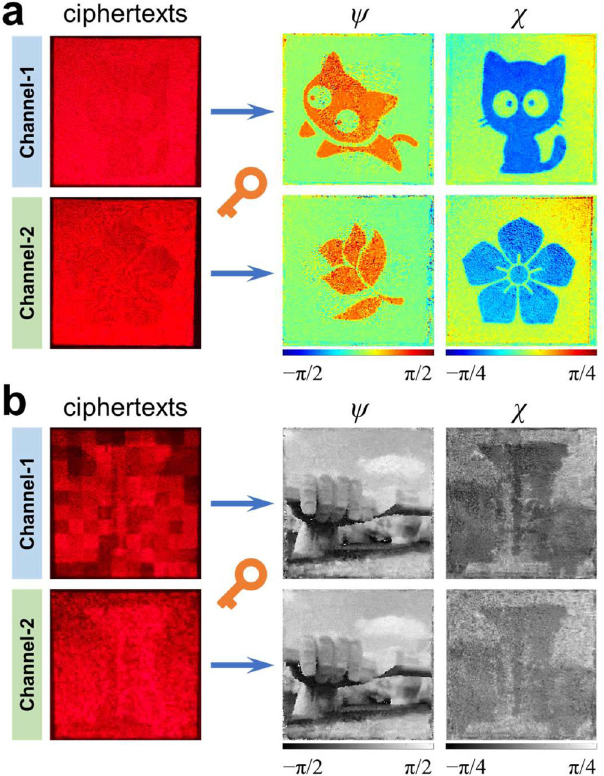
Fig. 4 | Angular vector encryption on Poincaré sphere. a , b Uniform and unu- niform ciphertext (total intensity I T ) encryptions. In a , two secret images are decrypted by characterizing an angular vector ( ψ , χ ) on the Poincaré sphere. In contrast, in b , two random intensity patterns (10 × 10pixels for channel-1 and 50× 50pixelsforchannel-2)areusedtoimprovethecon fi dentialityofthemeasurement of circularly polarized components. The two images are photographs of archi- tectureon the campus of Northwestern Polytechnical University and areused with permission of Northwestern Polytechnical